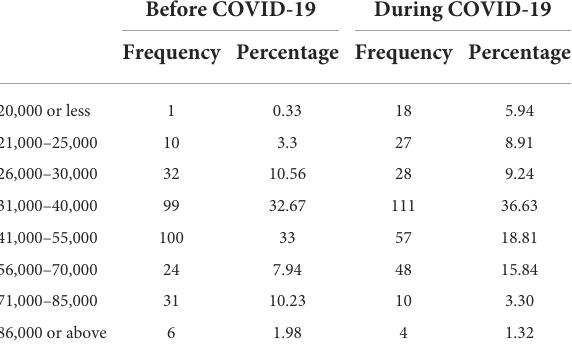
TABLE 2 Income distribution before and during COVID-19 (Unit: Pakistani Rupee). Before COVID-19 During